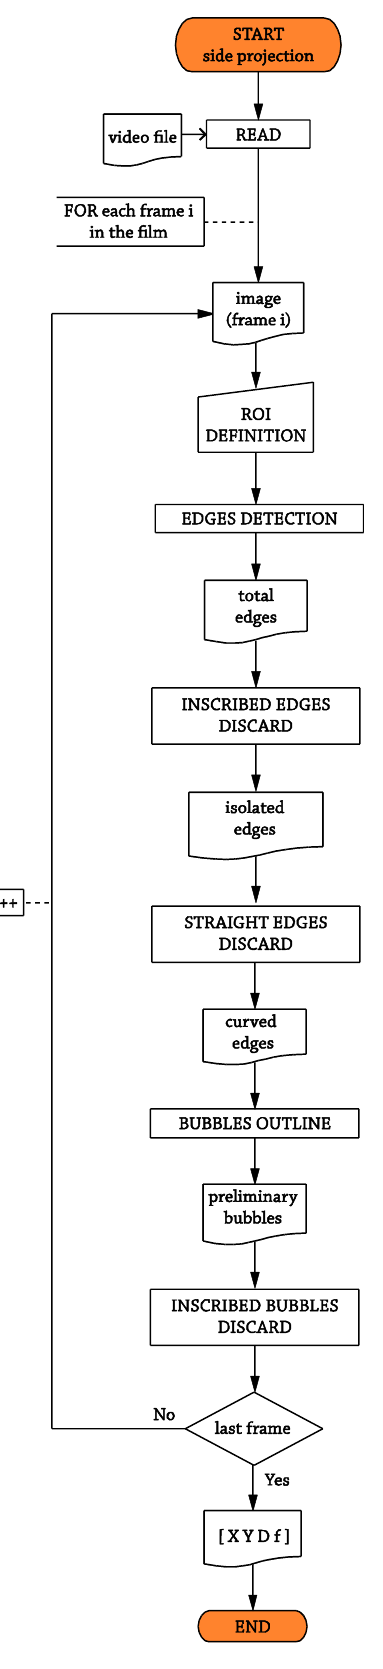
Figure 7. Flowchart for the side projection optical.